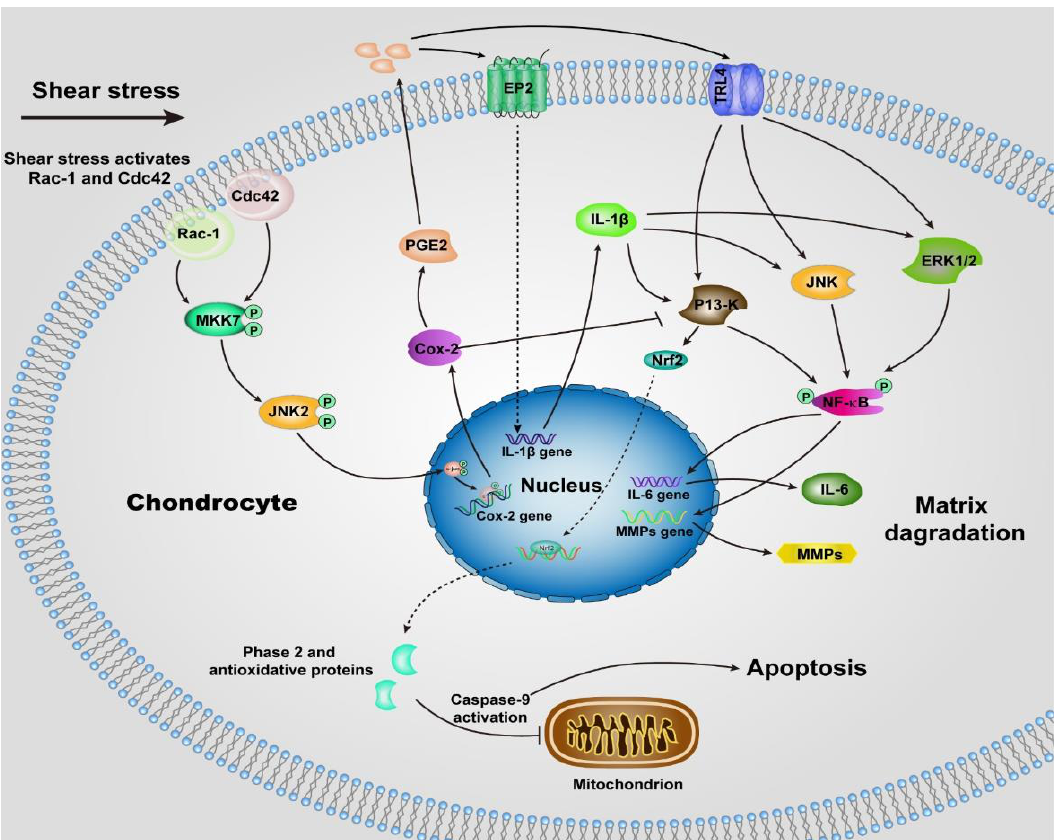
Figure 2. Schematic of shear-induced cartilage matrix degradation and apoptosis of chondrocytes. High shear stress activates the Rac-1/Cdc42, which then transactivates MKK7 to regulate JNK2 activation, and this, in turn, triggers c-Jun phosphorylation which induces the overexpression of Cox-2. Cox-2 suppresses the activity of P13-K, which represses Nrf-2 to decrease the antioxidant capacity to permit disruption of the integrity of mitochondrial, activation of caspase-9, and the apoptosis of chondrocytes. The expression of Cox-2 also triggers the expression of PGE2, as well as the concom- itant downstream expression of receptor EP2, as a result, IL-1b is rapidly and sustainably synthe- sized. Moreover, up-regulation of TLR4 due to high shear stress activates ERK1/2, P13-K and JNK